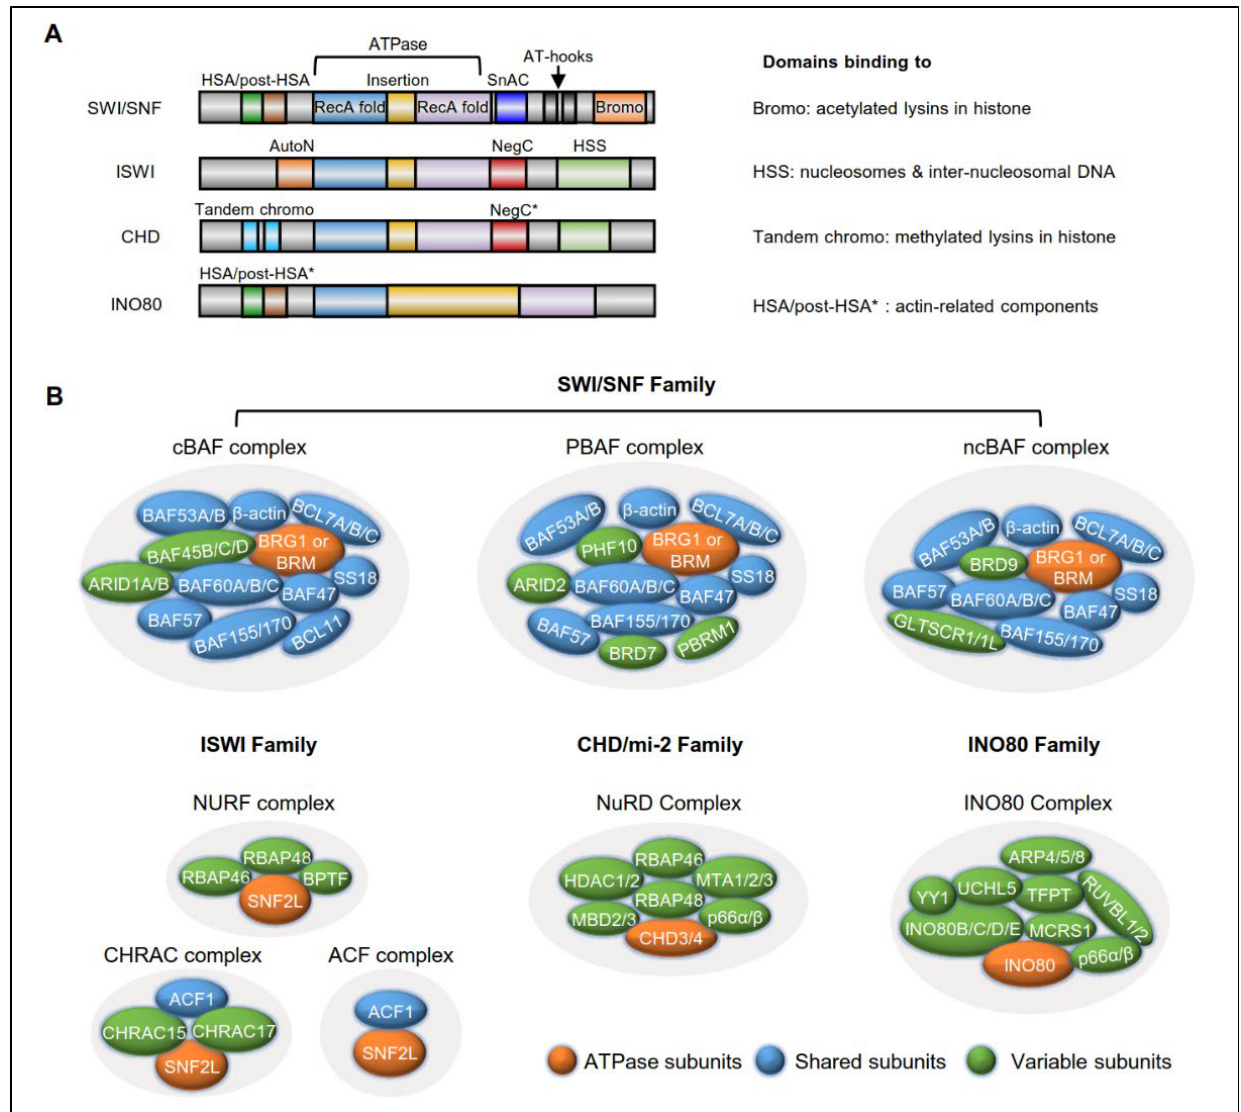
Figure 1. Domain organization and composition of chromatin-remodeling complex. ( A ) Domain organization of four chromatin remodeler complexes. Remodelers can be divided into four subfamilies according to the domain organization in the catalytic ATPases and their associated subunits. The ATPase domains in all of the remodelers are used to mobilize nucleosomes and comprise two RecA-like folds, which are separated by an insertion (yellow). Asterisk represents structural similarity. ( B ) The main complexes in each subfamily. The ATPase subunits, shared subunits, and variable subunits of the representative complexes in each of the four families of human chromatin remodelers.